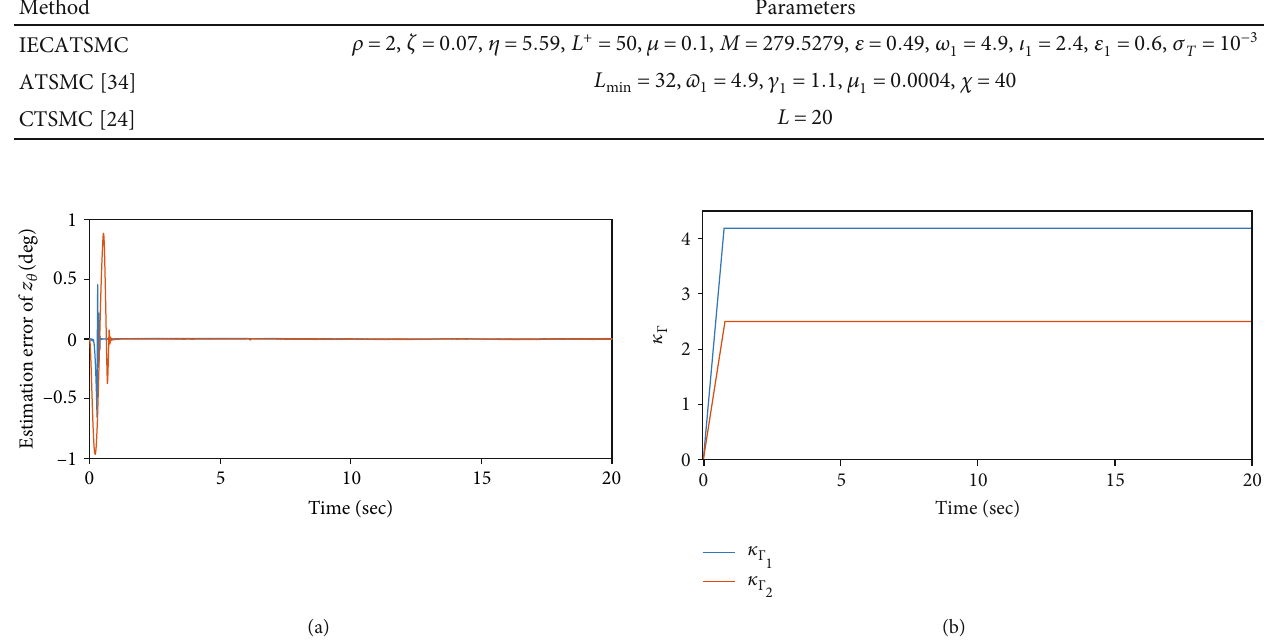
Figure 2: The curves of estimation errors and adaptive gains of the observer.